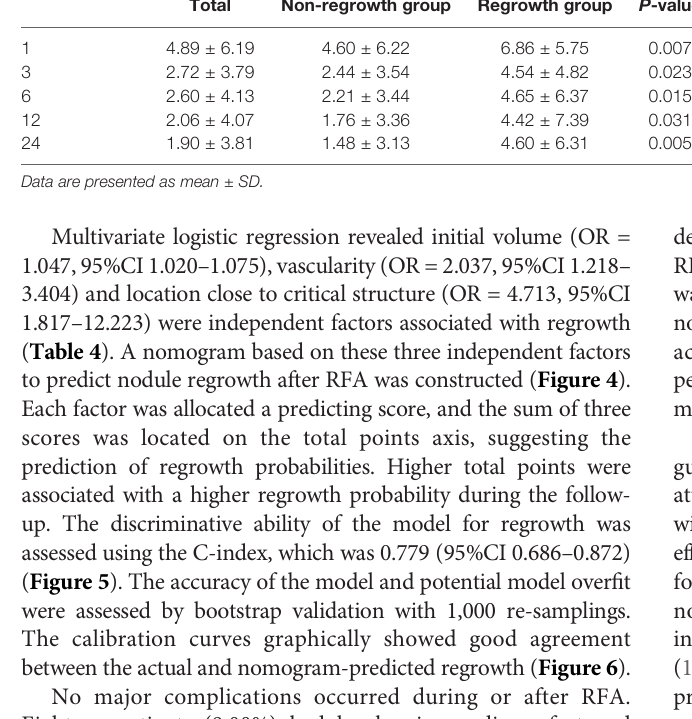
TABLE 2 | Changes of volume and VRR at each follow-up period after